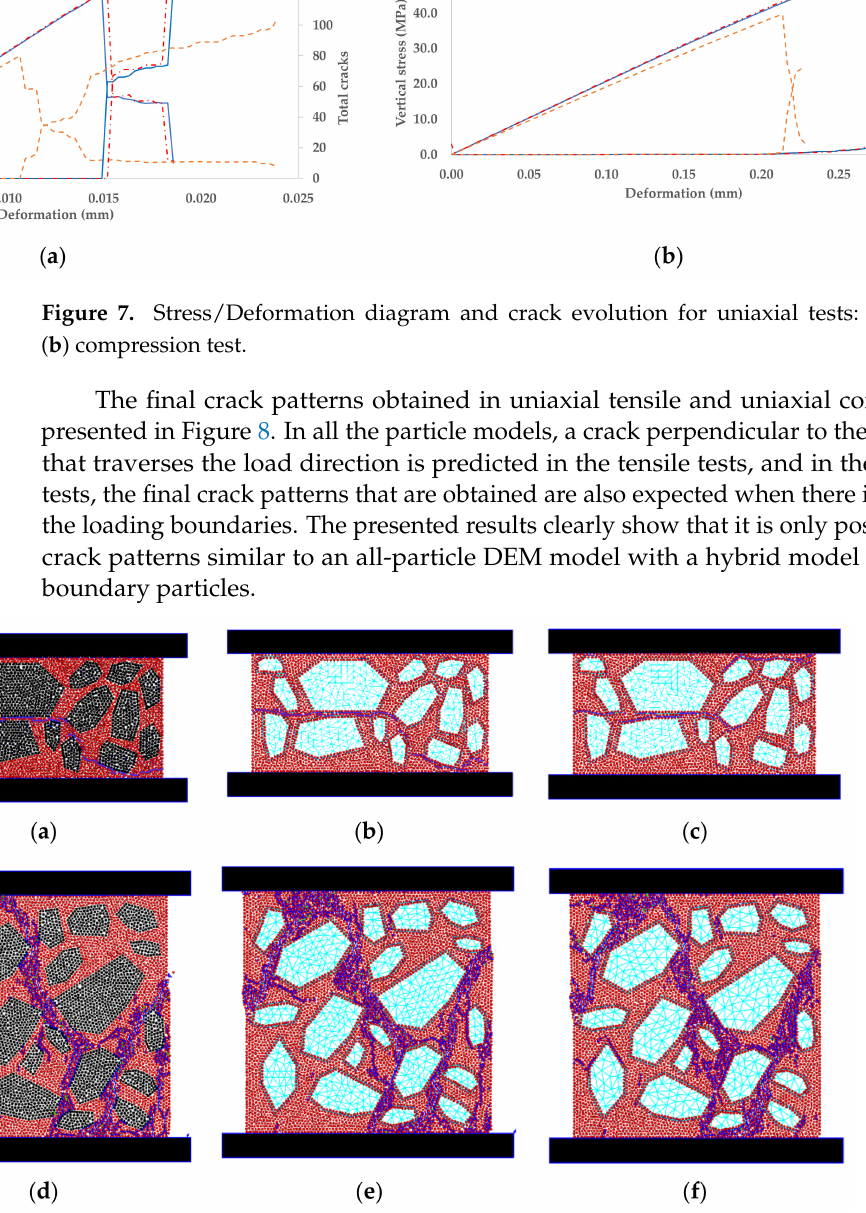
Figure 8. Final crack pattern for uniaxial testing: ( a ) Tensile test (DEM); ( b ) Tensile test (H-FEM- DEM-A); ( c ) Tensile test (H-FEM-DEM-B) [15]; ( d ) Compression test (DEM); ( e ) Compression test (H-FEM-DEM-A) and ( f ) Compression test (H-FEM-DEM-B)